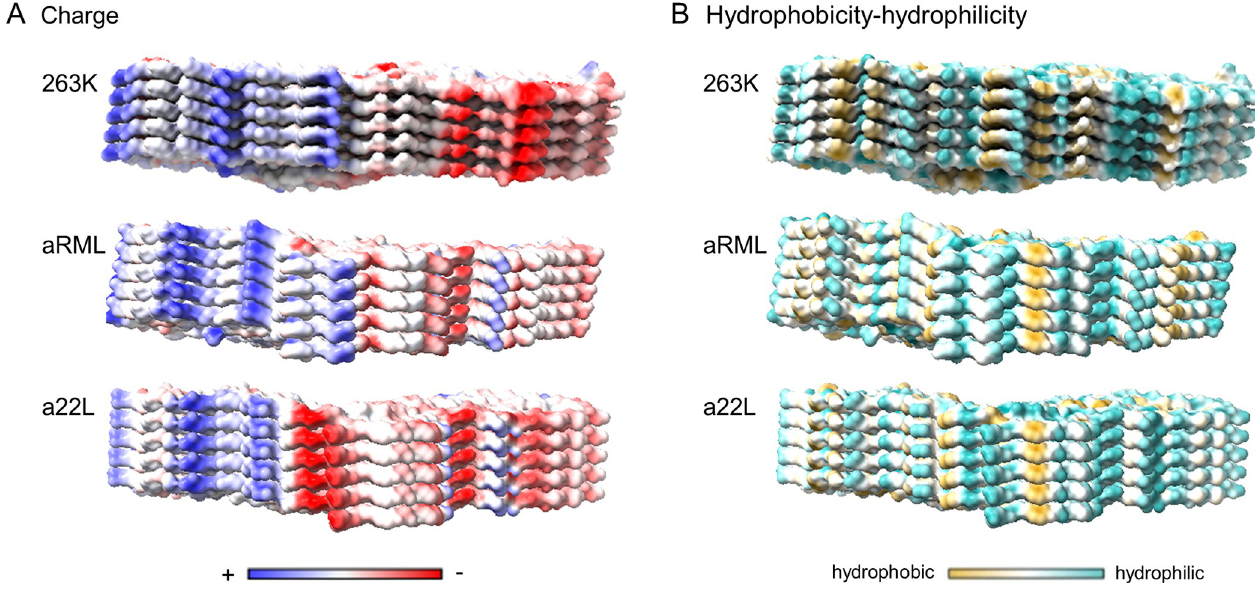
Fig 6. Strain-dependent distributions of coulombic charges and surface hydrophobicity. (A) Coulombic charge distributions in 263 K (PDB: 7LNA) [6], aRML (PDB: 7TD6) [5] and a22L (PDB: 8EFU) prion strains. (B) Hydrophobicity distributions. These analyses were performed in ChimeraX 1.4.